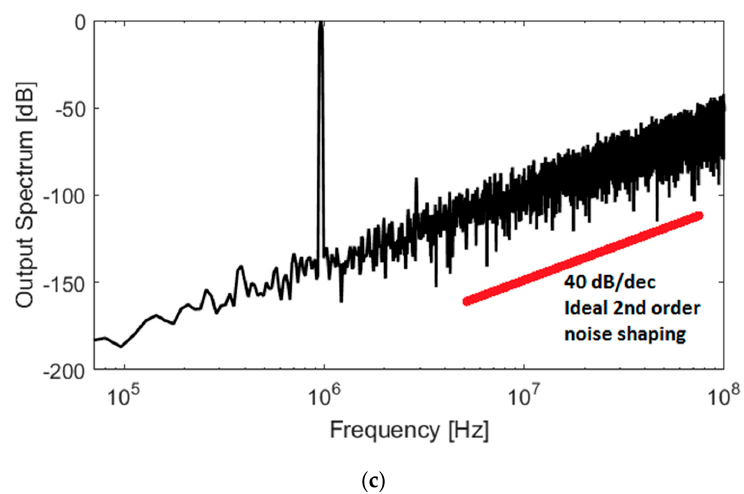
Figure 11. Measured output spectrum of the proposed 1-1 MASH TDC. ( a ) f S1 = 200 MHz and f S2 = 200 MHz; ( b ) f S1 = 200 MHz and f S2 = 800 MHz; ( c ) f S1 = 400 MHz and f S2 = 1600 MHz.